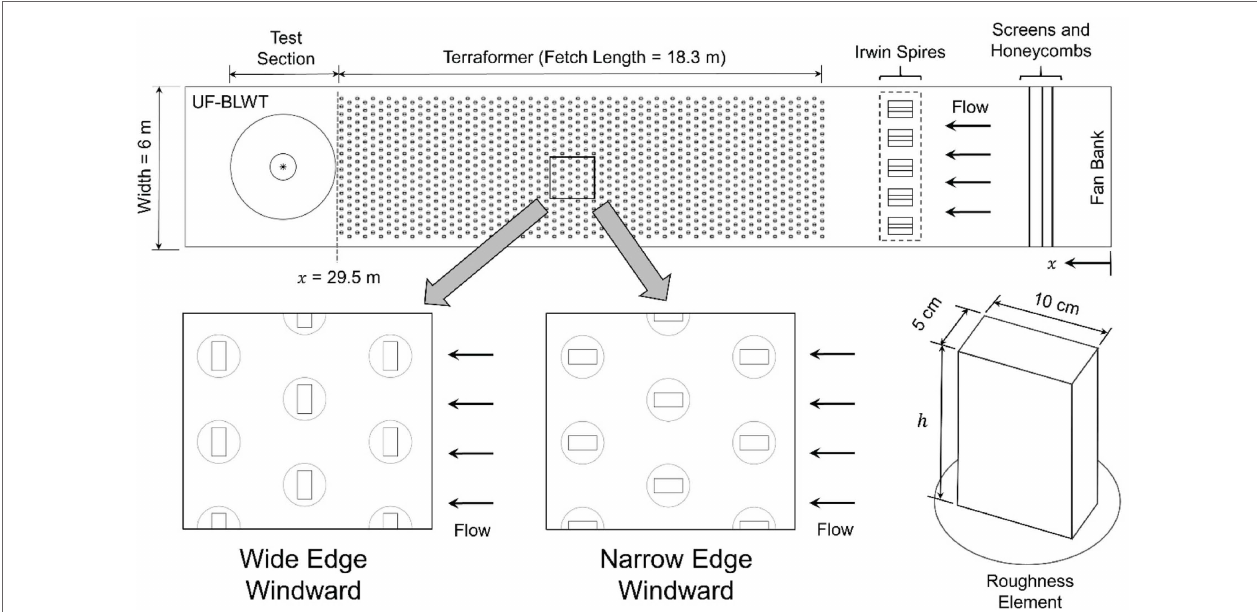
FIGURE 1 | Plan view of the boundary layer wind tunnel (BLWT) at the University of Florida, illustrating the two element orientations considered for this study, namely wide, and narrow edge windward. (Reprinted from Fernández-Cabán and Masters, 2017 with permission from Elsevier).